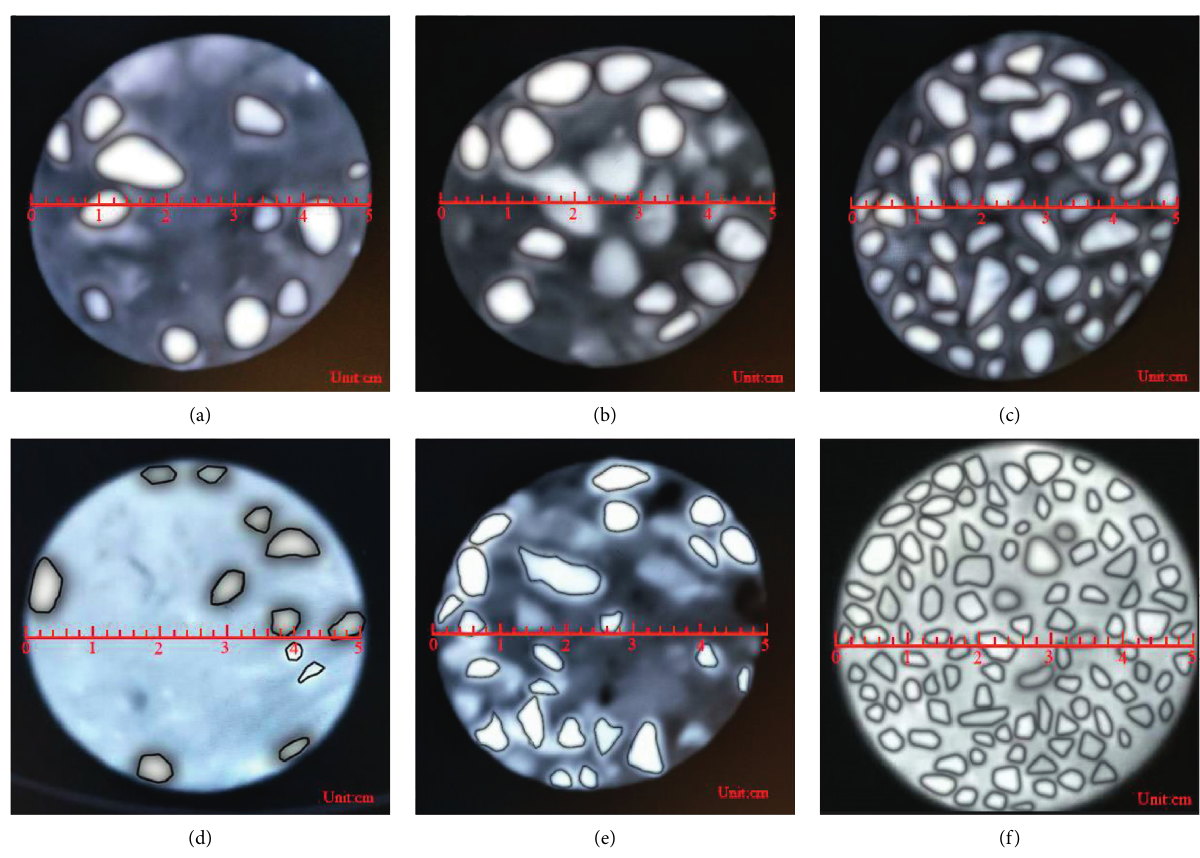
Figure 12: CTsection images of soil-rock mixtures with different rock contents and shapes. (a) 10% round rocks. (b) 30% round rocks. (c) 60% round rocks. (d) 10% angular rocks. (e) 30% angular rocks. (f) 60% angular